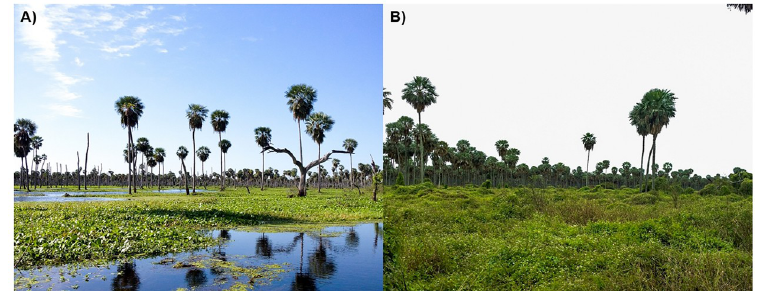
Fig 7. Different landscape characteristics at La Estrella marsh. A) Navigable area, suitable for hunting yellow anacondas ( Eunectes notaeus ). B) Area of difficult access where yellow anacondas are not hunted. Photos by B.